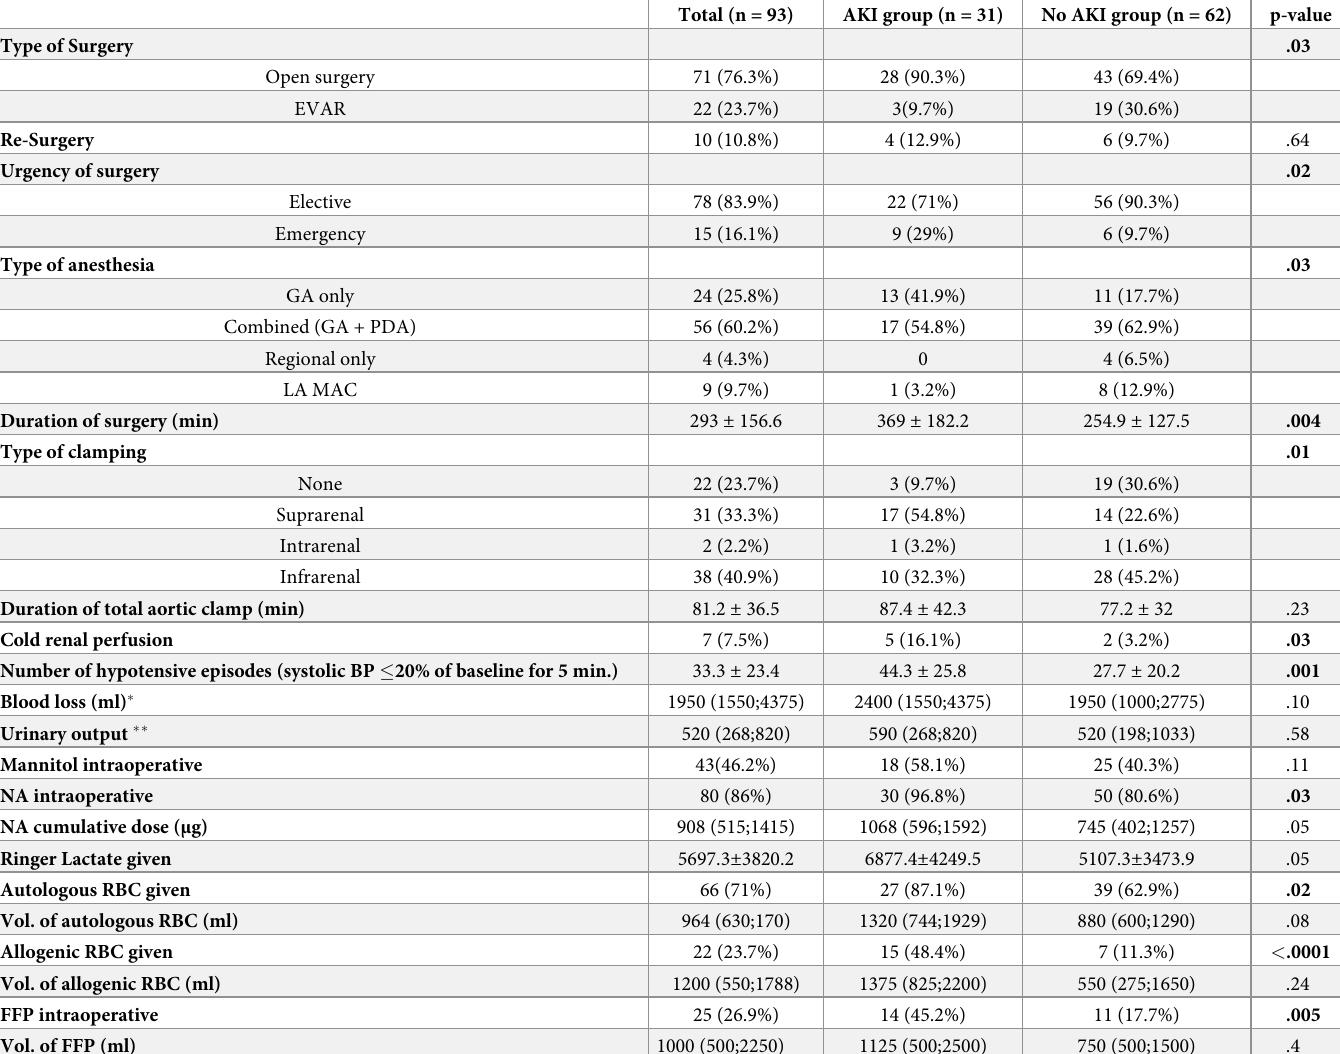
Table 2. Intraoperative patient